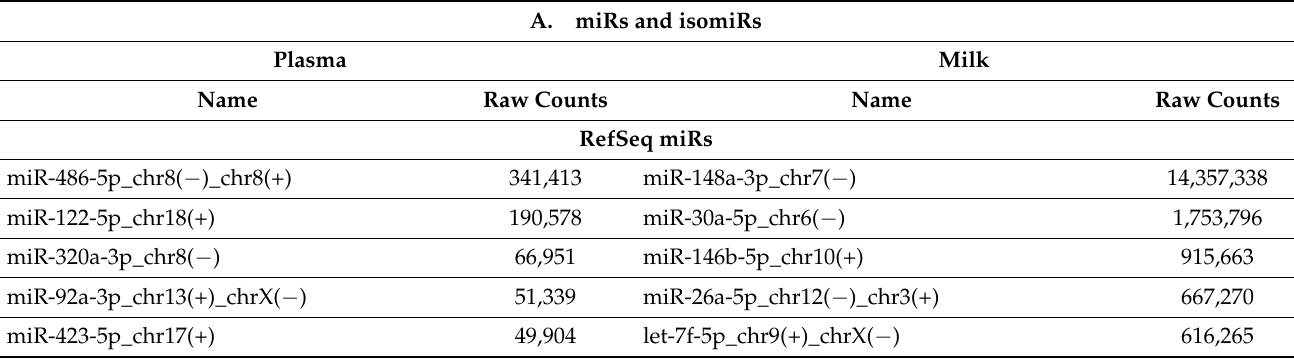
Table 1. ( A ) The most abundant RefSeq miRs, template (t) and non-template (nont) isomiRs in all milk and plasma samples [34] detected by miRGalaxy. ( B ) The most abundant RefSeq miRs, template (t) and non-template (nont) isomiRs in all cancer (PDAC) and control (asymptomatic individuals) samples [35] detected by